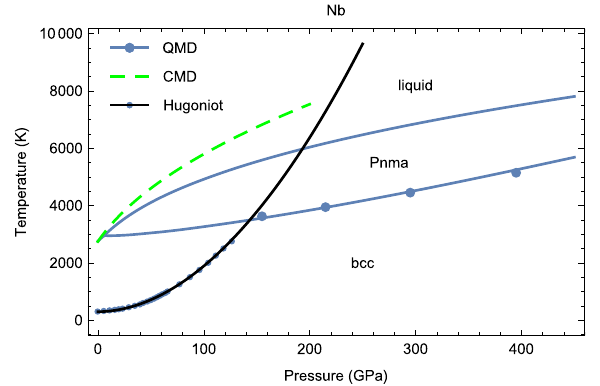
Fig. 6 The ab initio phase diagram of Nb. The theoretical Hugoniot points of ref. 65 are shown for comparison with our Hugoniot (black line). Also shown is the melting curve of ref. 42 obtained from classical molecular dynamics (CMD, green dashed line). The error bars of the quantum molecular dynamics (QMD) points are smaller than the size of the symbol.